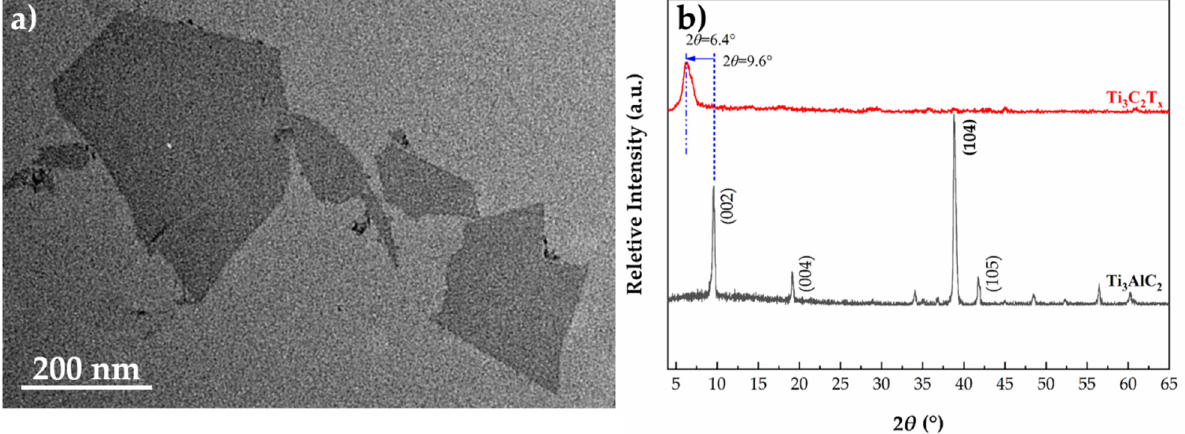
Figure 2. TEM image of Ti 3 C 2 T x dispersed in distilled water ( a ) and XRD pattern of Ti 3 C 2 T x powder ( b ).